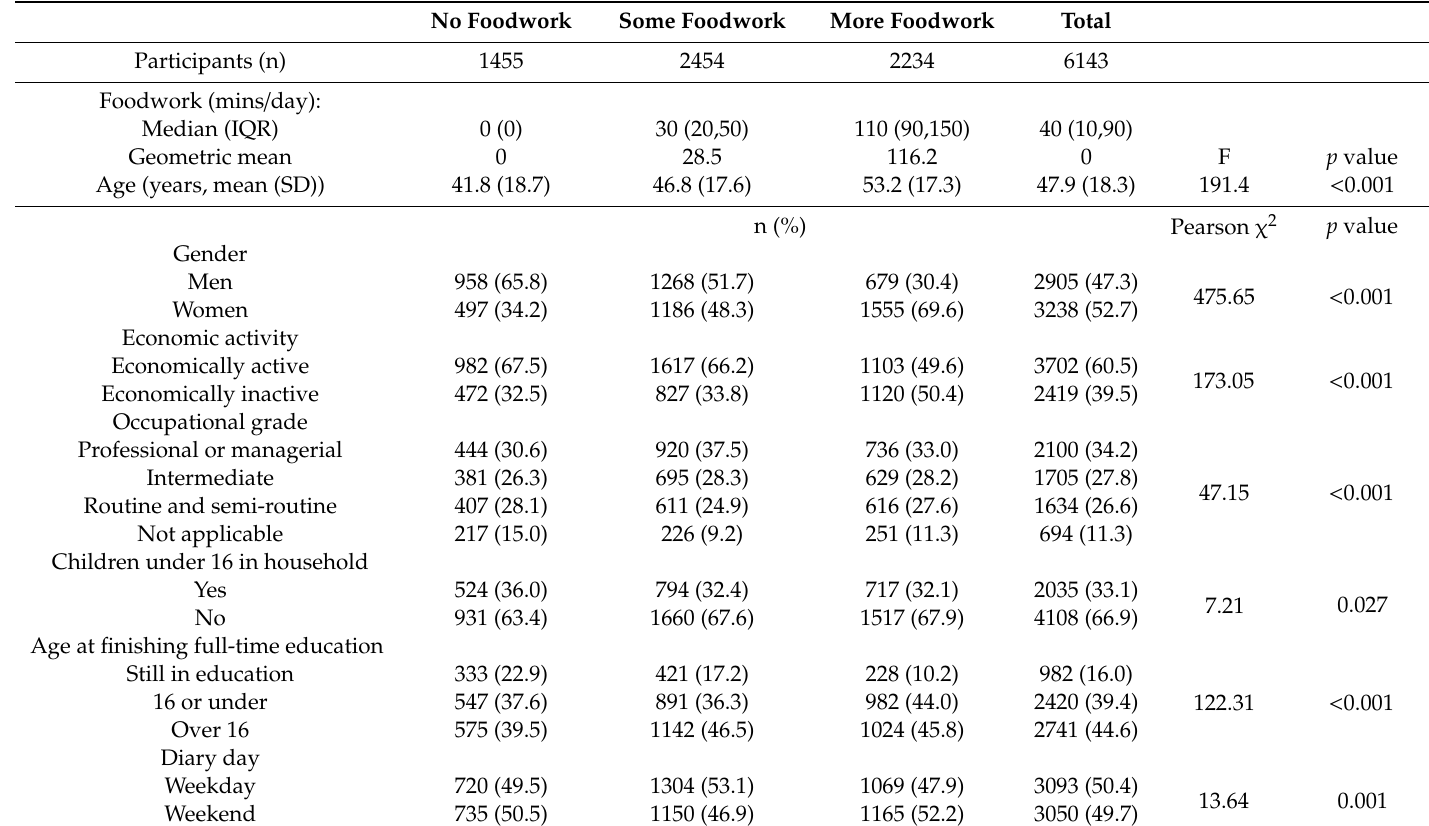
Table 1. Characteristics of analysis sample (n =